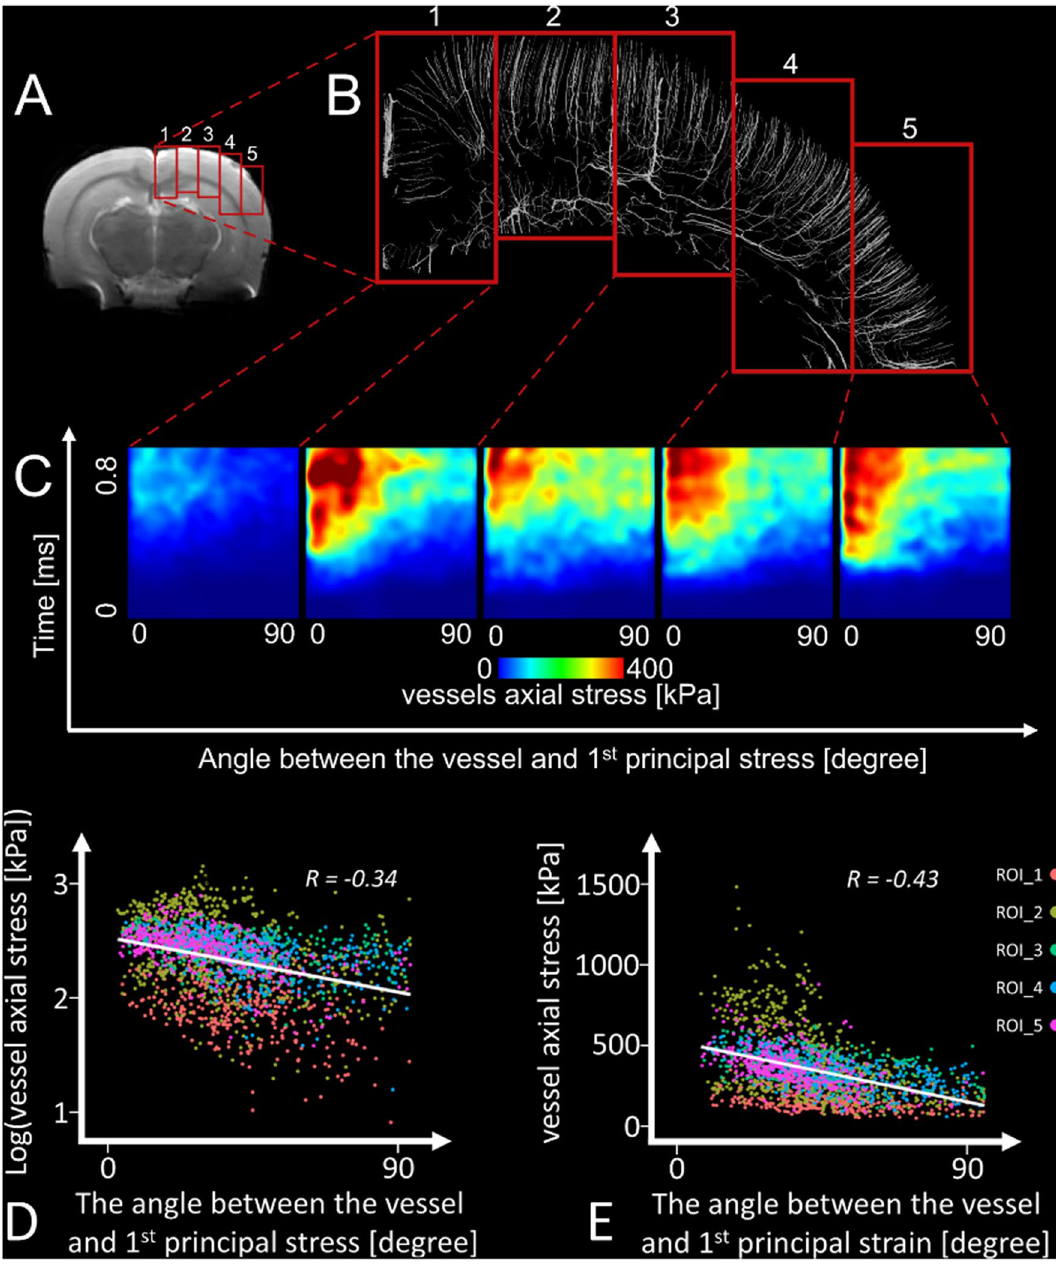
Figure 4. Microscale simulation for 5 ROIs. ( A ) The location of regions of interest. These regions of interest are in the ipsilateral hemisphere of the brain (cortex and corpus callosum) below the impact where the model predicts the highest strain and shear stress (Fig. 1), ( B ) the magnified view of the vessels within the regions of interest, ( C ) vessels’ axial stress as a function of time and the angle between the vessels and the direction of the 1st principal stress of the neighbouring tissue. Vessels axial stress raises as the time passes and as the angle between the vessel and direction of 1st principal stress of the vessels’ neighbouring tissue goes towards zero. ( D ) Linear regression between the logarithm of the vessels’ axial stress and the angle between the vessels and the direction of the 1st principal stress. ( E ) Linear regression between the vessels’ axial stress and the angle between the vessels and the direction of the 1st principal found strong correlation between the area of Fibrinogen extravasation and the area of brain with vessels under axial stresses in excess of 200 kPa, equivalent to 0.14 axial strain considering the linear elastic model used for vessels. Shear stress and strain in the parenchyma have been suggested as predictors of BBB damage in previous studies 24,35–37 . For instance, it has been shown that the BBB breakdown in a rat model can occur at maximum principal logarithmic strains in the parenchyma larger than 0.19. However, these previous works lacked a descrip- tion of vasculature, which limited their study to the correlation between stress and strain in parenchyma and